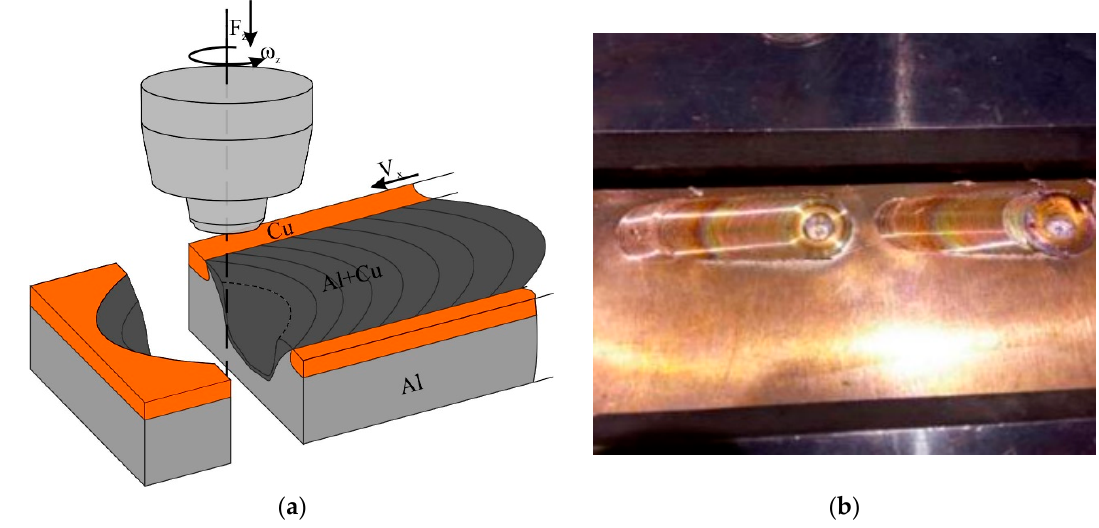
Figure 1. Scheme of FSP on С 11000/A5056 sandwich ( a ) and single-pass FSP seams ( b ).